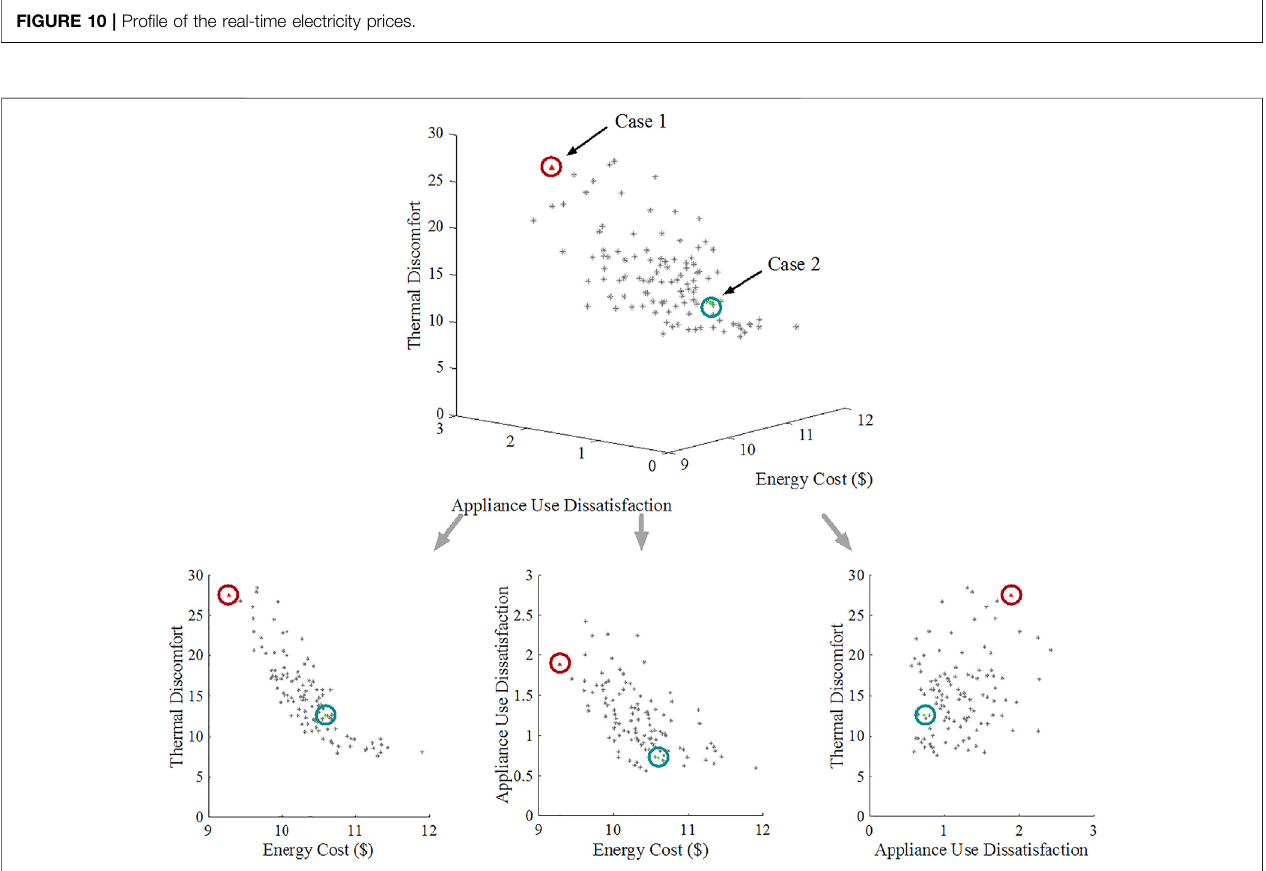
FIGURE 11 | Obtained non-dominated home energy management solutions.